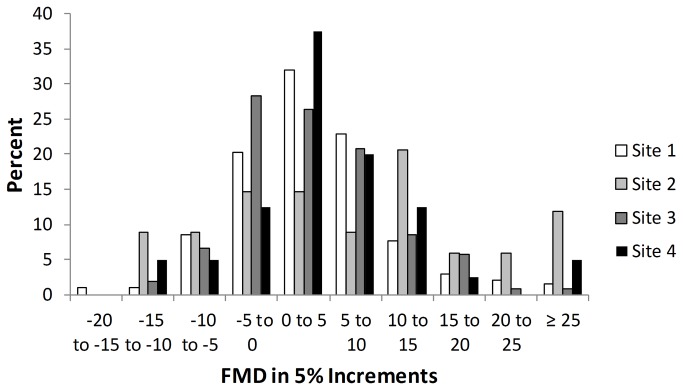
Distribution of Brachial Artery Reactivity by Clinical Site.